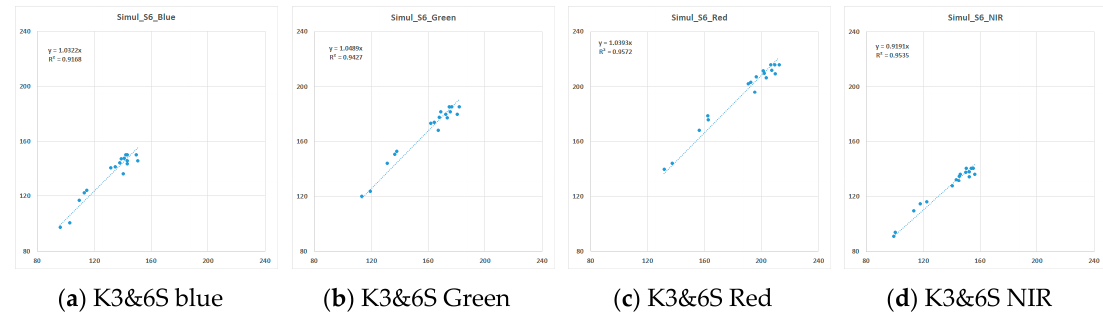
Figure 6. Measured by KOMPSAT-3A (K3A) and simulated by 6S over the Libya-4 PICS TOA radiance (X: front, Y: rear).